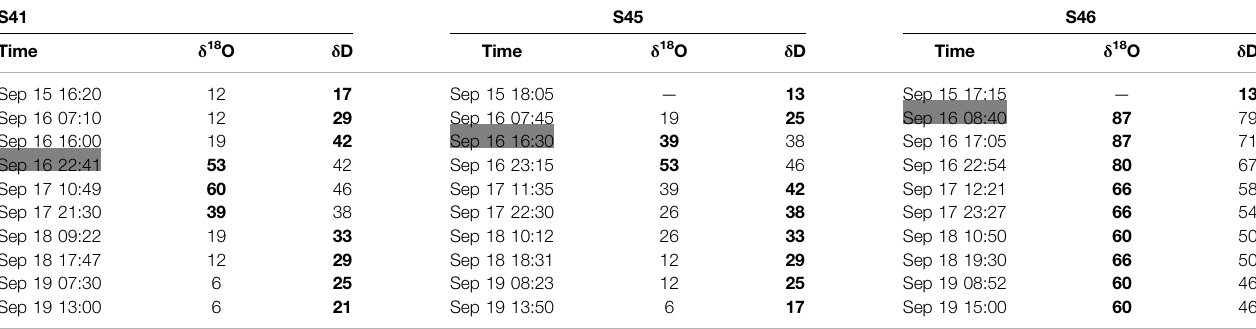
TABLE 3 | Contribution (%) of rainfall (R) to discharge at three Type Ⅱ springs during the storm event in Figure 2B . The remaining was assumed to come from pre-storm water (PS; deep groundwater). The bigger proportion of R between those using δ 18 O and δ D was in bold. Time for peak fl ow was shaded in gray. S41 S45